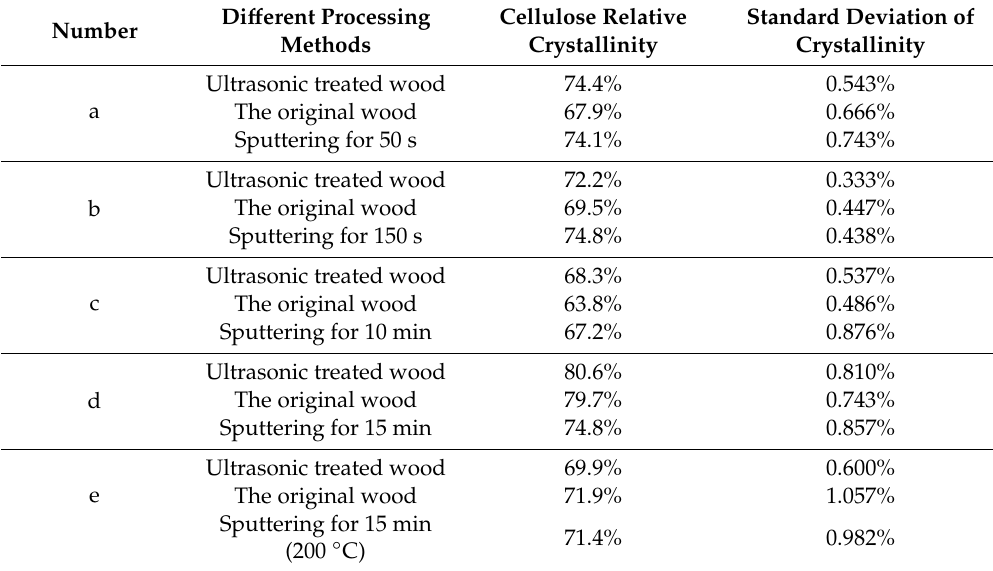
Figure 4. XRD map of wood veneer under different treatments in the range of 40° to 80°. Table 2. Crystallinity of samples after different treatment.